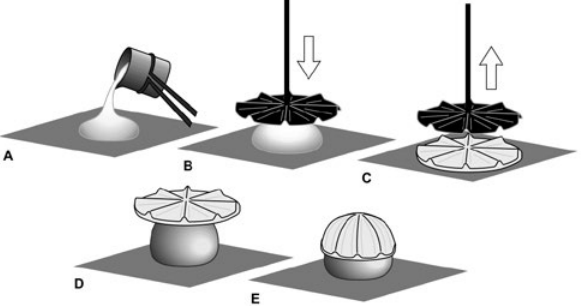
Figure 7. Ribbed bowl (1st century CE) [81.10.39; Courtesy of The Metropolitan Museum of Art, www.metmuseum.org].